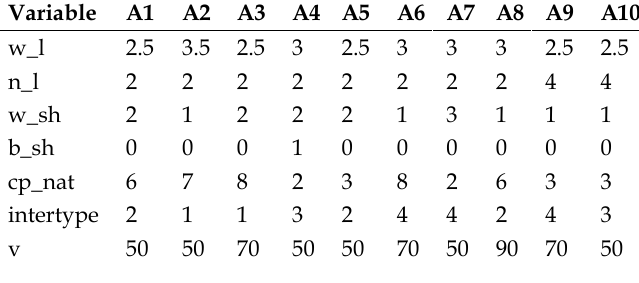
Table 5. Definition of the alternatives of the case study